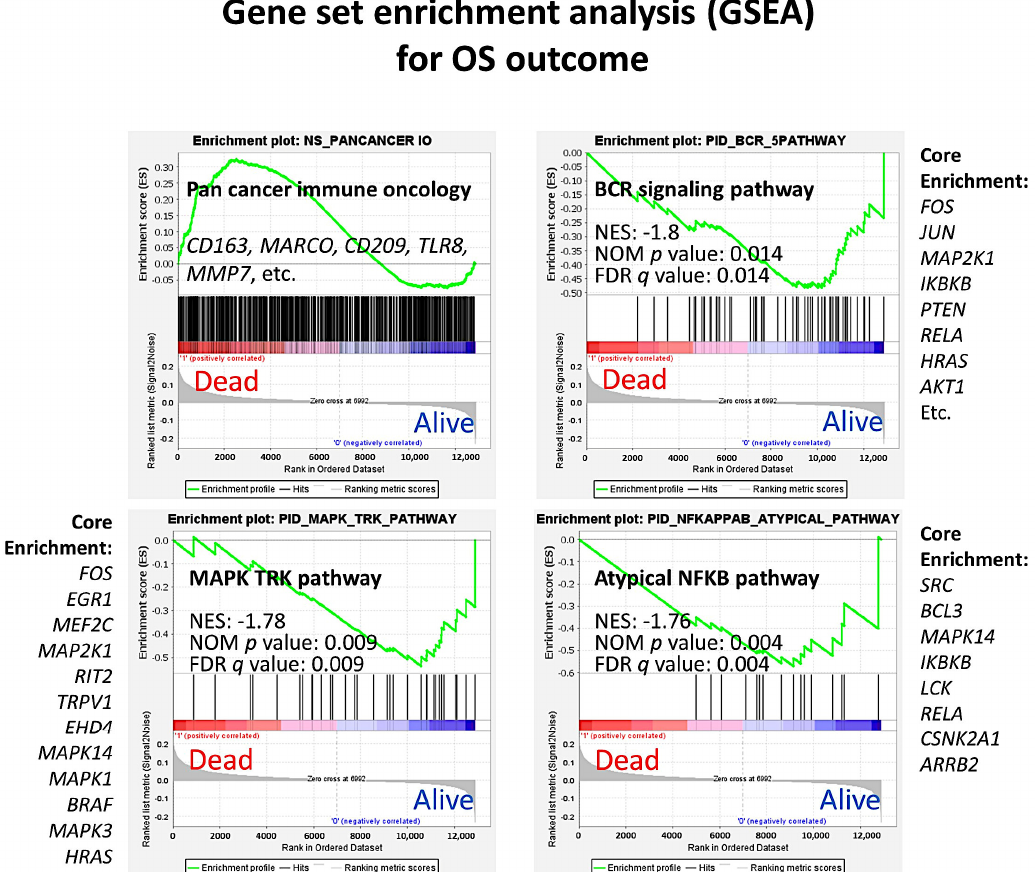
Figure 4. Clinicopathological characteristics of the series: Gene set enrichment analysis (GSEA).